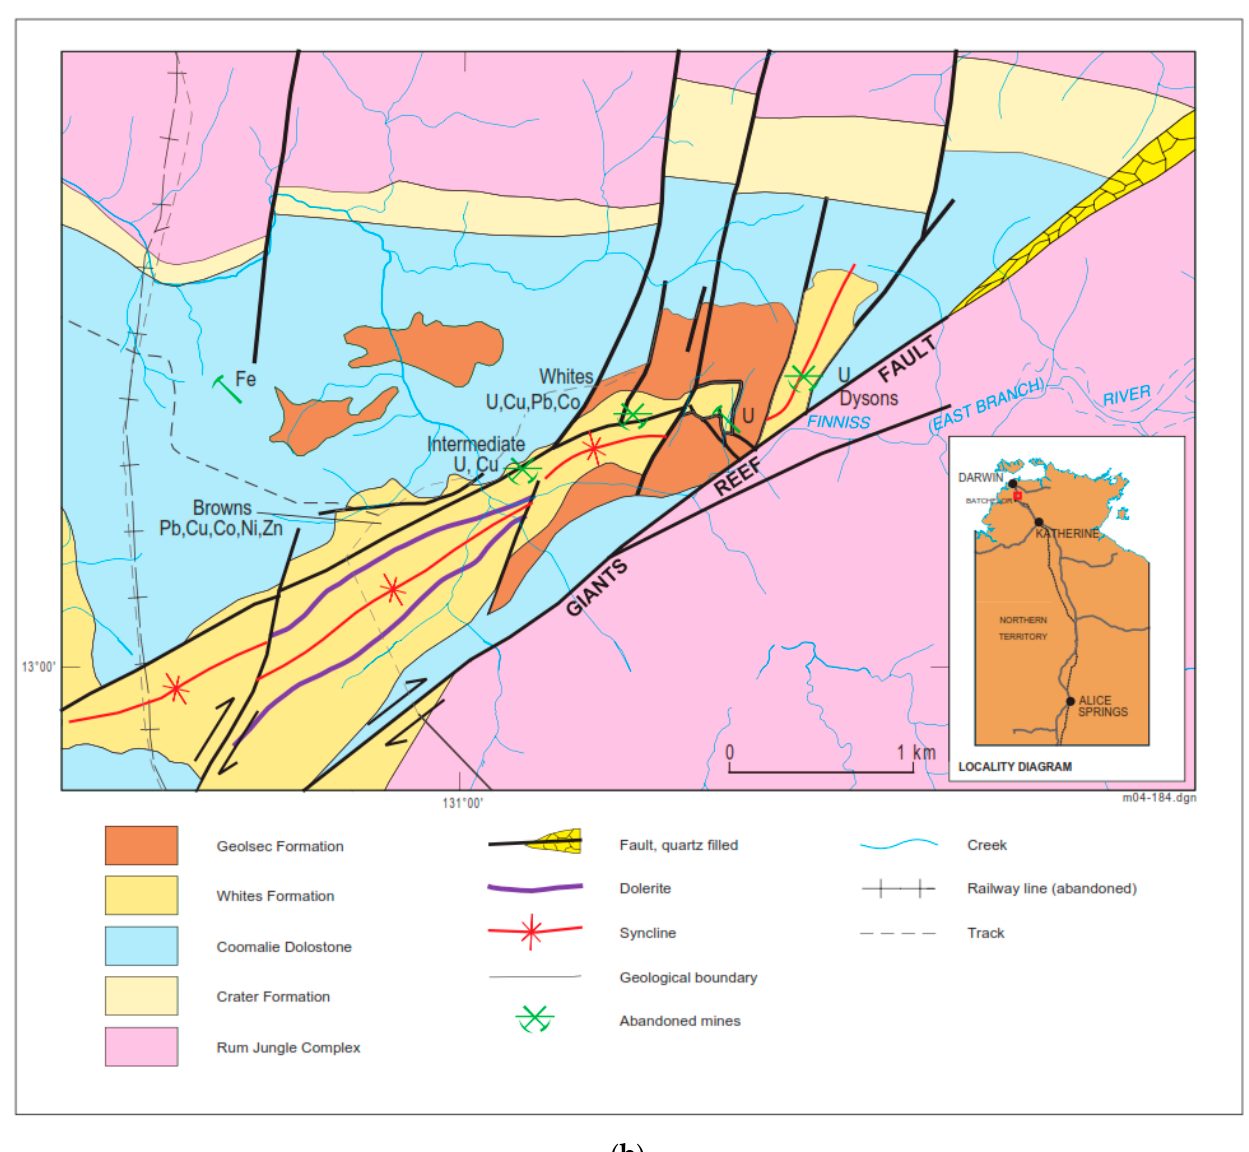
Figure 1. ( a ) A layout map of the Rum Jungle Mine site [33]. ( b ) A geological and mineral deposits map of the Rum Jungle Mine area [34].